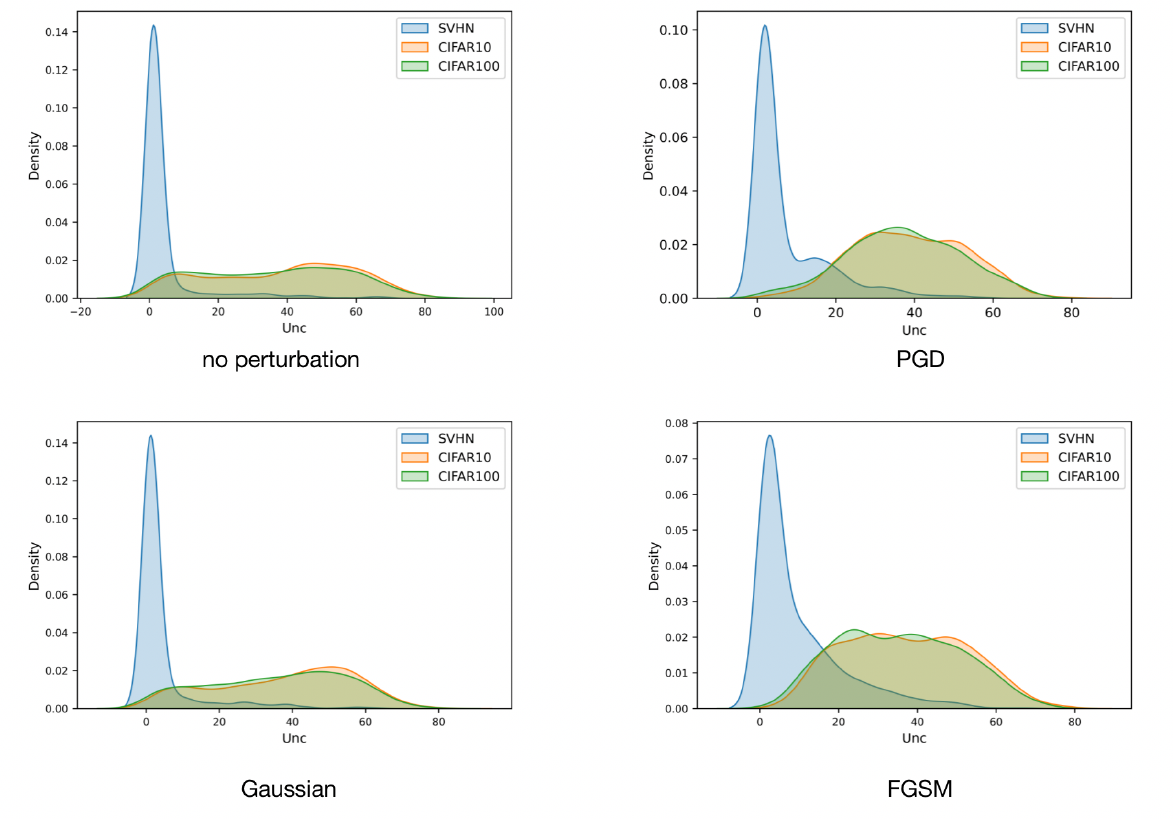
Figure 3. The distribution of uncertainty calculated on samples with the application of different types of perturbations. We use SVHN as the ID dataset and CIFAR10 and CIFAR100 as the OOD